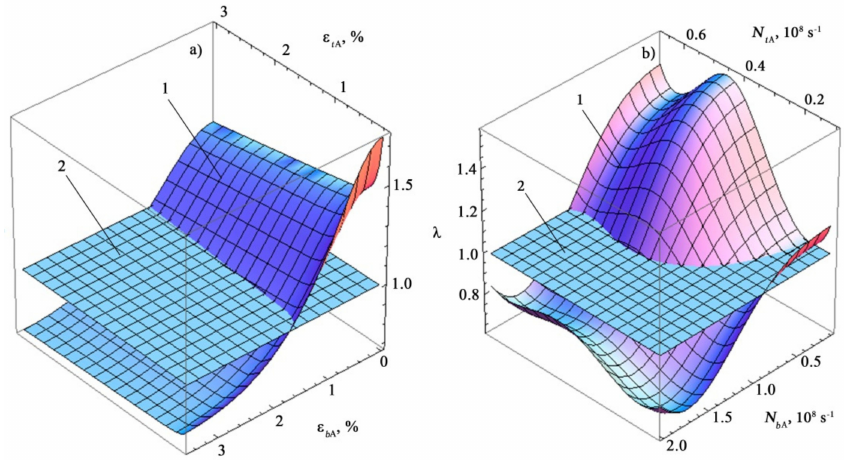
Figure 12. Three-dimensional image of the safety factor depending on changes in acoustic ( a ) and deformation ( b ) characteristics under different types of loading: 1-response surface, 2-equilibrium surface λ =